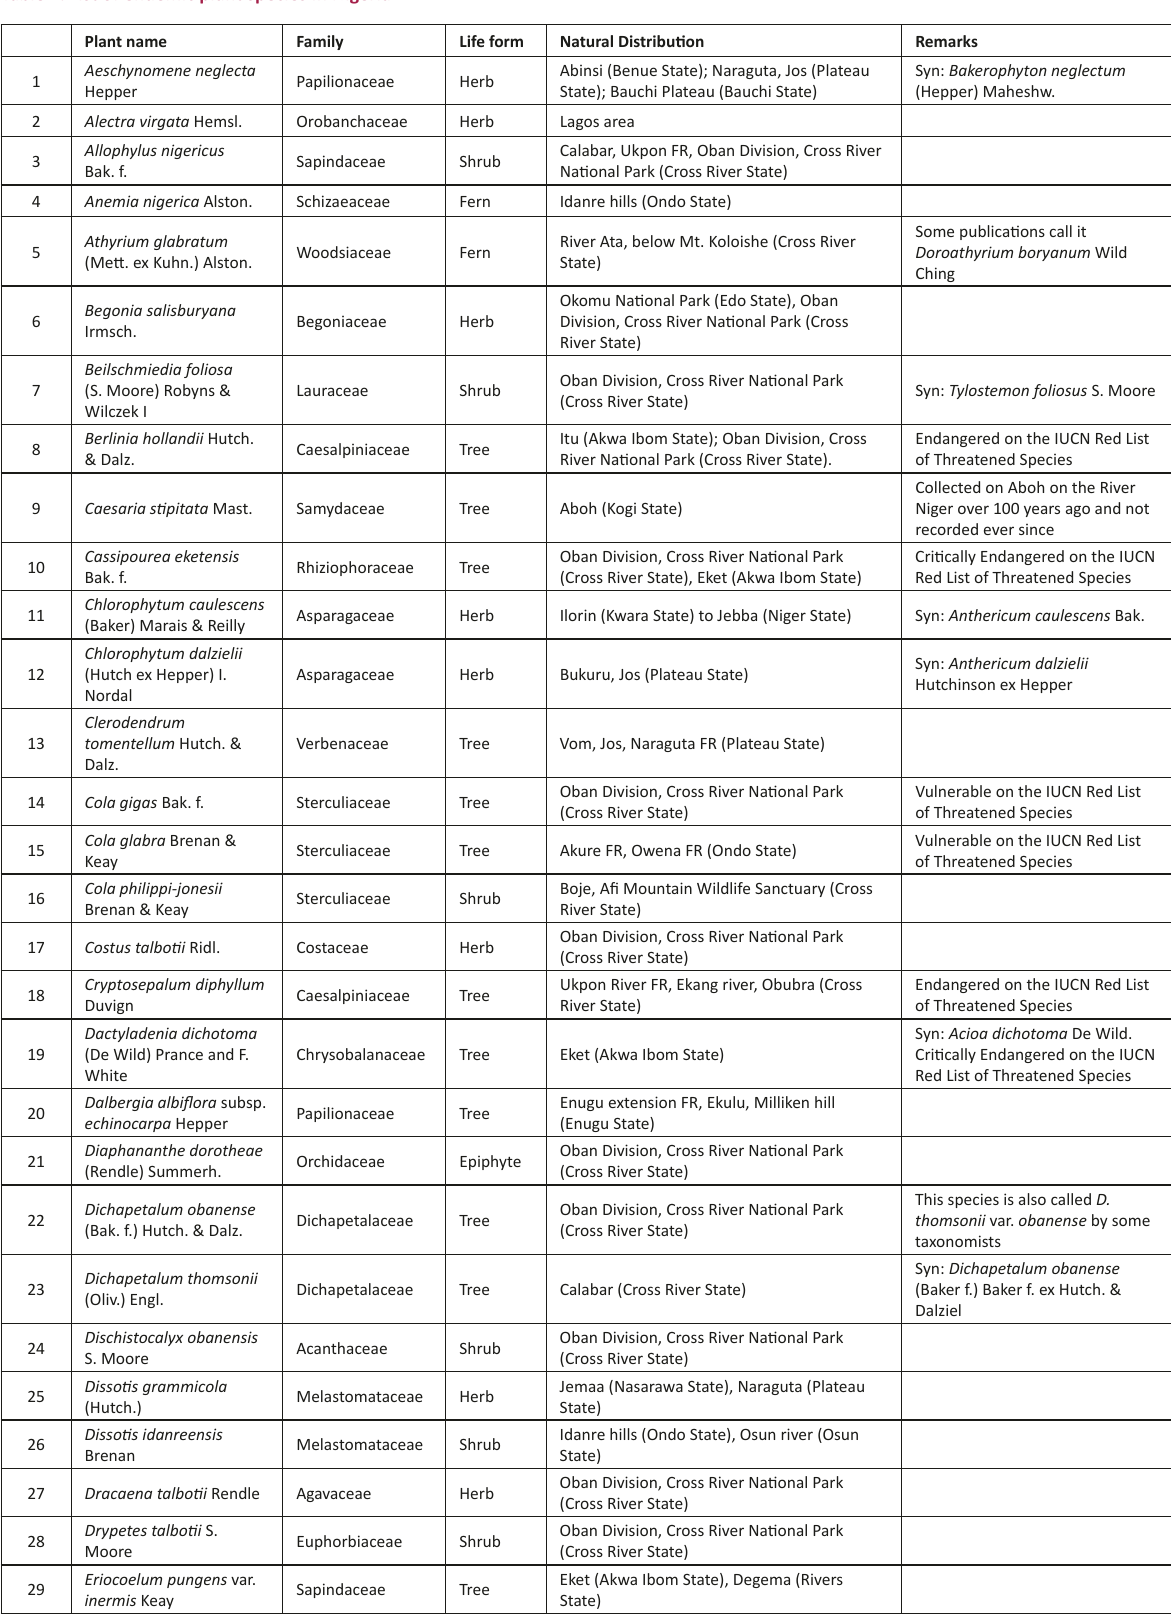
Table 1. List of endemic plant species in